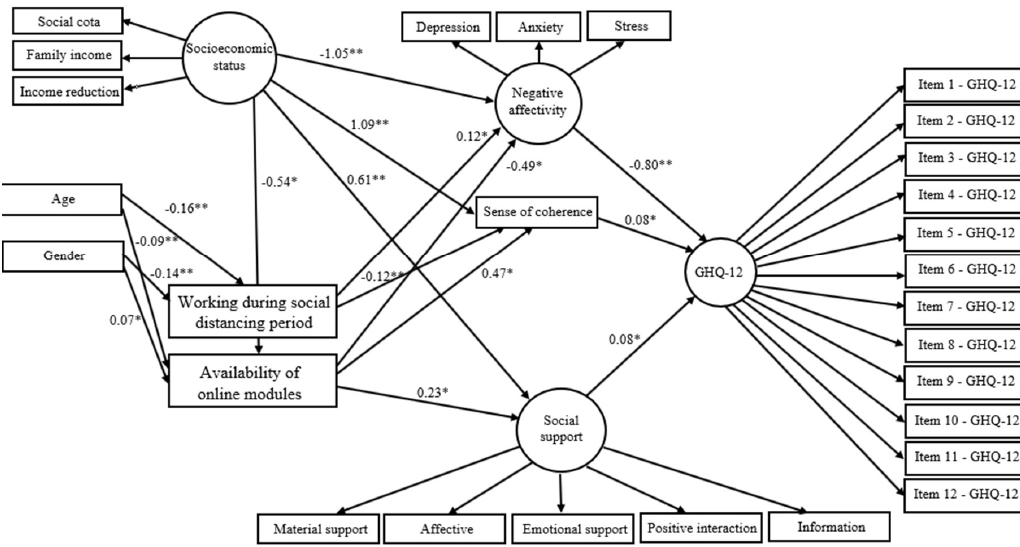
Figure 3. Direct effects showing the standardized estimates for the parsimonious model. * p < 0.05, ** p <